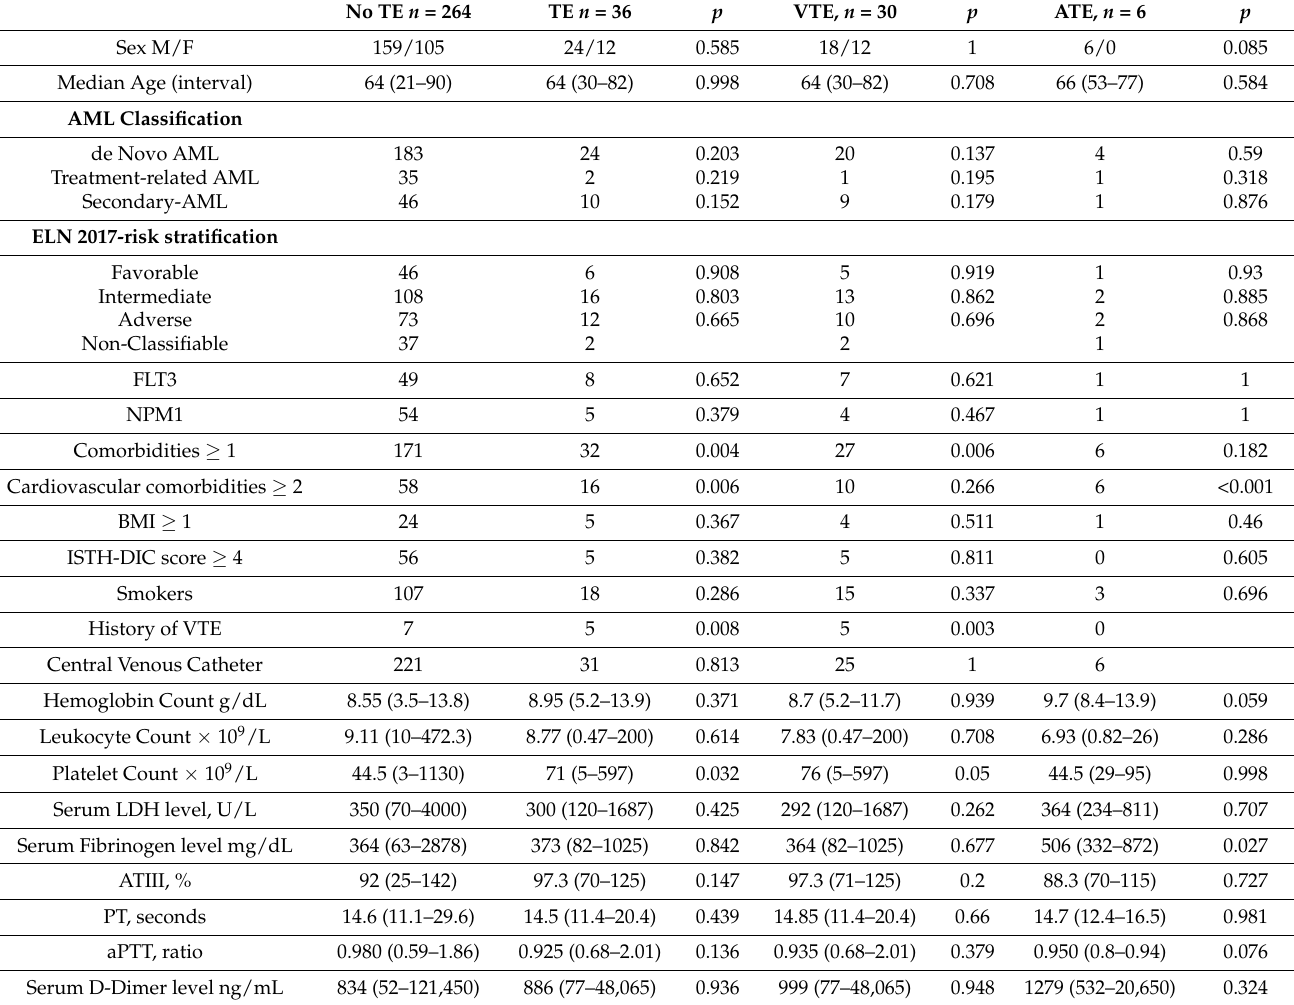
Table 1. Baseline patient’s